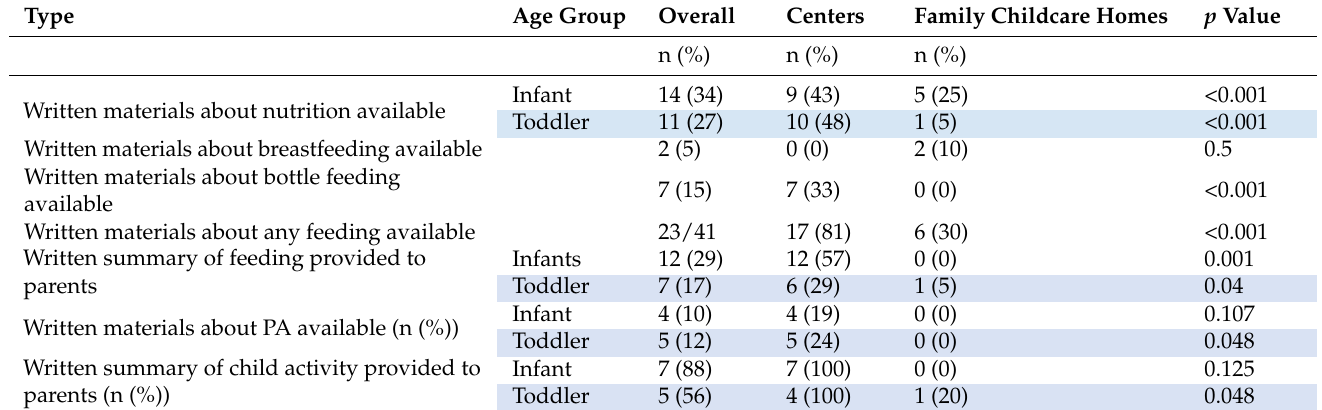
Table 5. Communication materials visible in childcare and summaries available for